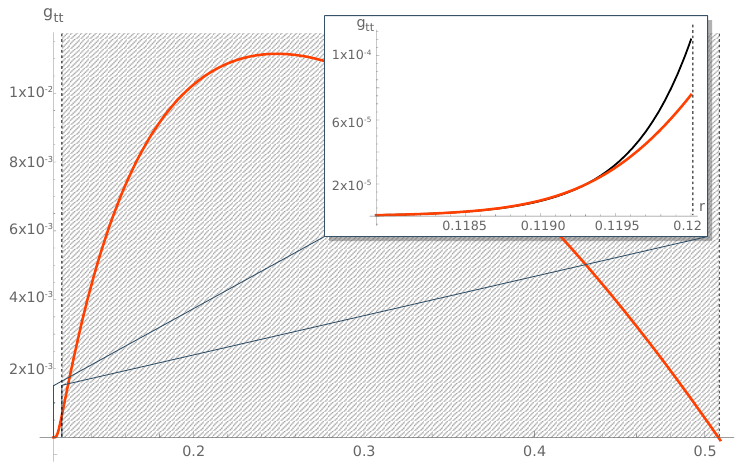
Figure 5 . Full non linear evolution (color) and approximate solution (black) for g tt close to the collapse of the Einstein-Rose bridge. The dashed region is excluded from the fit, and corresponds to the probe and polynomial epochs mentioned in the previous